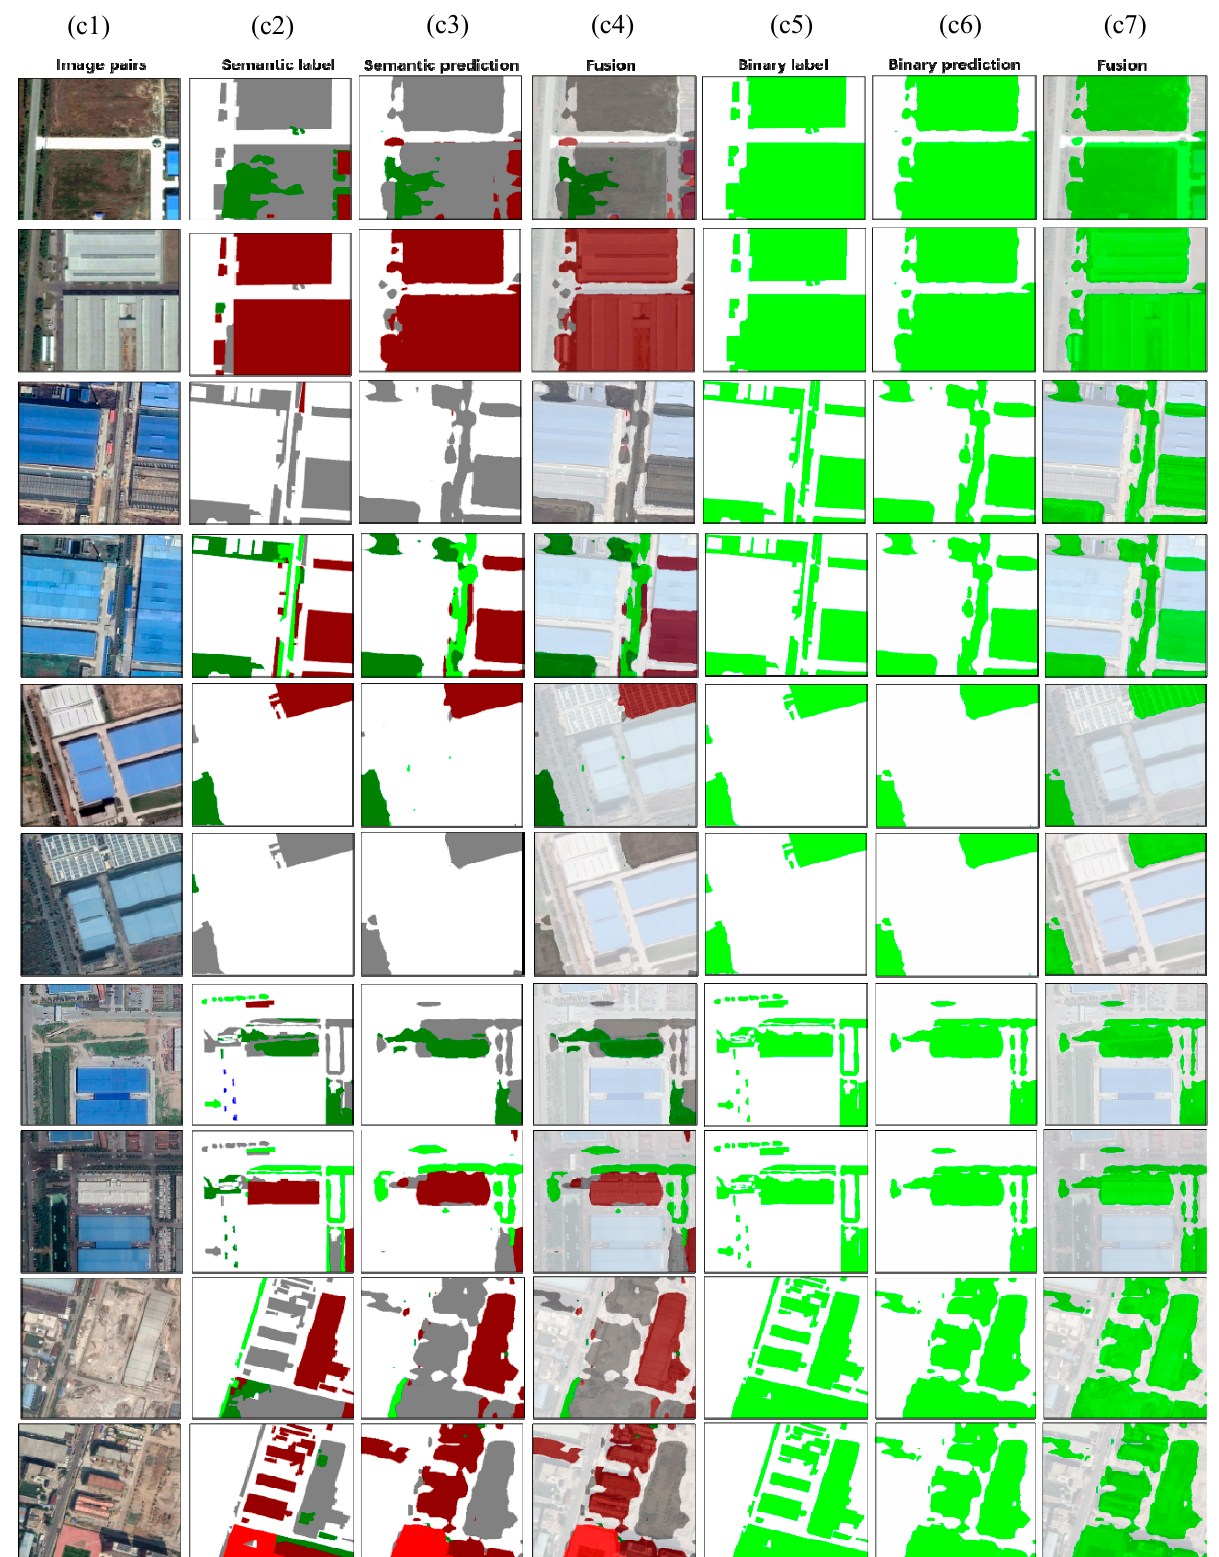
Figure 4. Semantic change maps and binary change maps generated by GCF-SCD-Net. c1 is an image pair; c2 and c3 are the semantic label and prediction; images in c4 were obtained by fusing the raw images and semantic prediction masks; c-5,6,7 represent the binary change label, binary change prediction and binary fusion